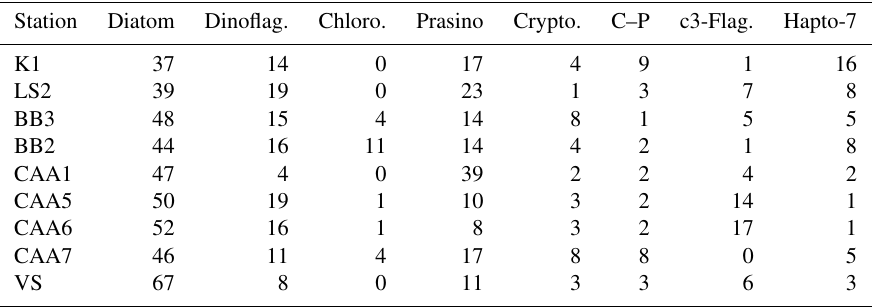
Table 3. CHEMTAX-derived phytoplankton assemblage estimates (numbers given are percent of total chl a ) for sampled stations. Diat. is di- atoms; Dinoflag is Dinoflagellates; Chloro. is Chlorophytes; Prasino is Prasinophyte (types 2 and 3); Crypto. is Cryptophytes; Chryso-Pelago is Chrysophytes/Pelagophytes; c3-flag. is c3-Flagellates; Hapto-7 is Haptophyte type 7. Due to the presence of unidentified phytoplankton taxa, not all assemblage estimates sum to 100%.